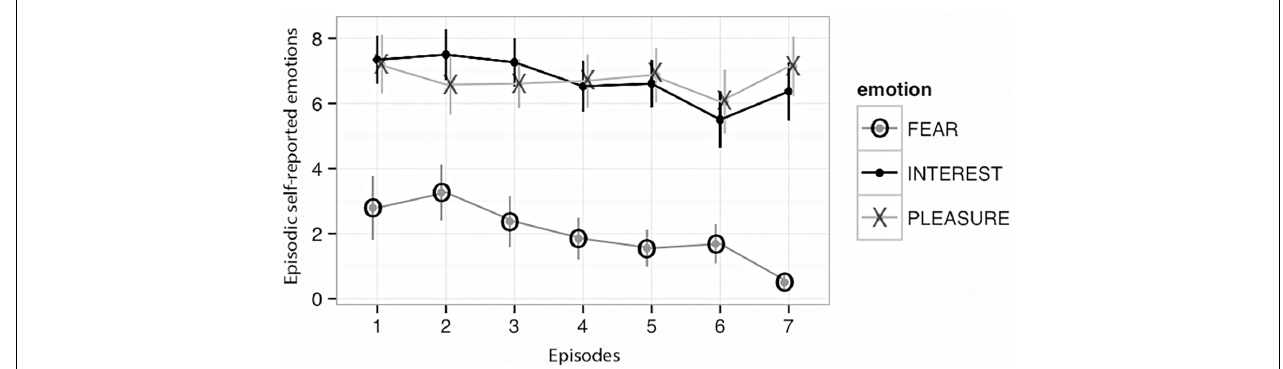
FIGURE 4 | Mean self-reported episodic fear, interest and pleasure for the seven episodes.